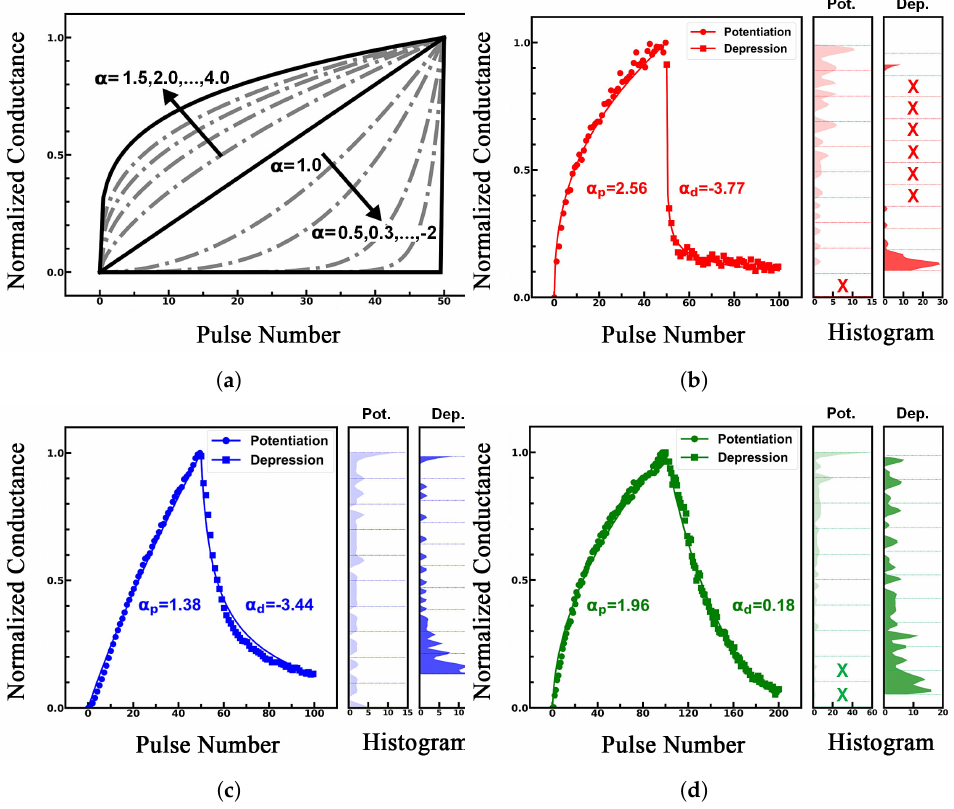
Figure 2. The synaptic characteristics including the potentiation, depression characteristics of the synaptic devices; ( a ) modeling function, ( b ) PCMO, ( c ) LiCoO 2 , and ( d ) TiO x devices for identical pulses and the histogram of measured conductance values on 10 level. The points correspond to measured conductance values and the solid line represents the modeling